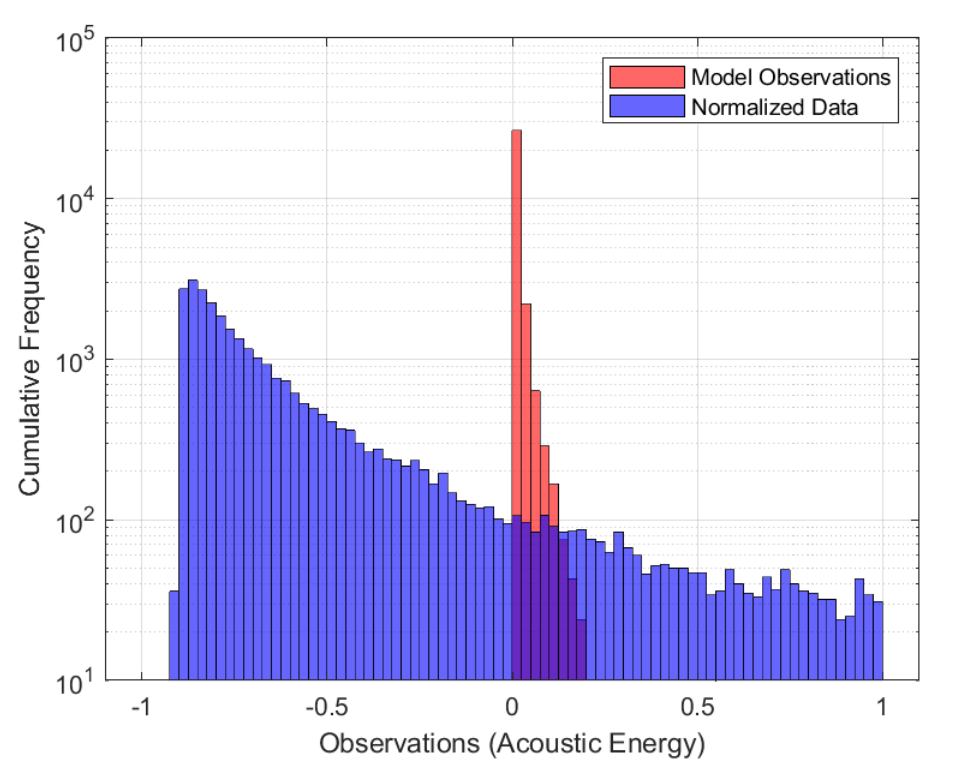
Figure 5. Histogram of the input data before and after normalization and